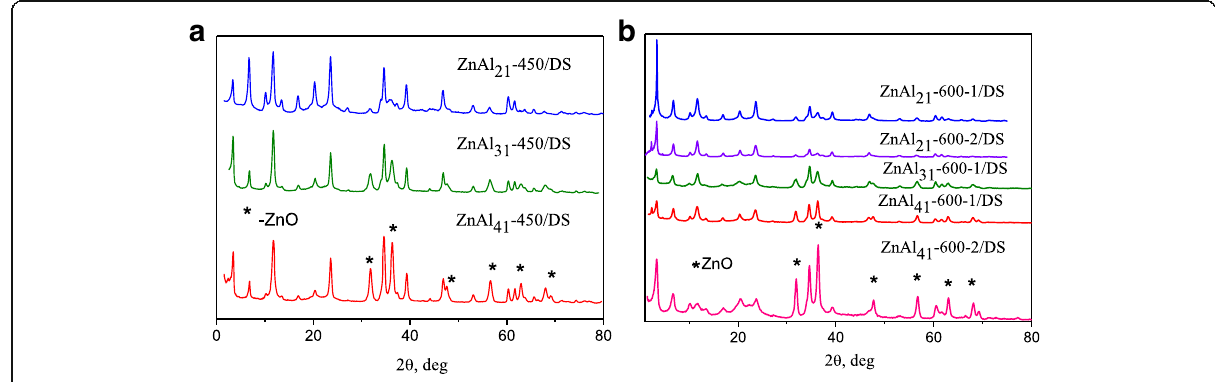
Fig. 2 X-ray diffraction patterns of DS modified Zn-Al LDHs obtained by reconstruction of LDHs calcined at 450 °C ( a ) and 600 °C ( b )